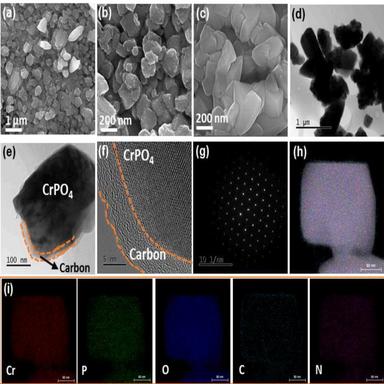
Morphology and structure characterizations of CrPO4@NC and CrPO4 samples. SEM images of CrPO4@NC (a,b) and CrPO4 (c); (d,e) TEM images, (f) HRTEM image, (g) SAED pattern, and (h,i) EDS mappings of CrPO4@NC composite.